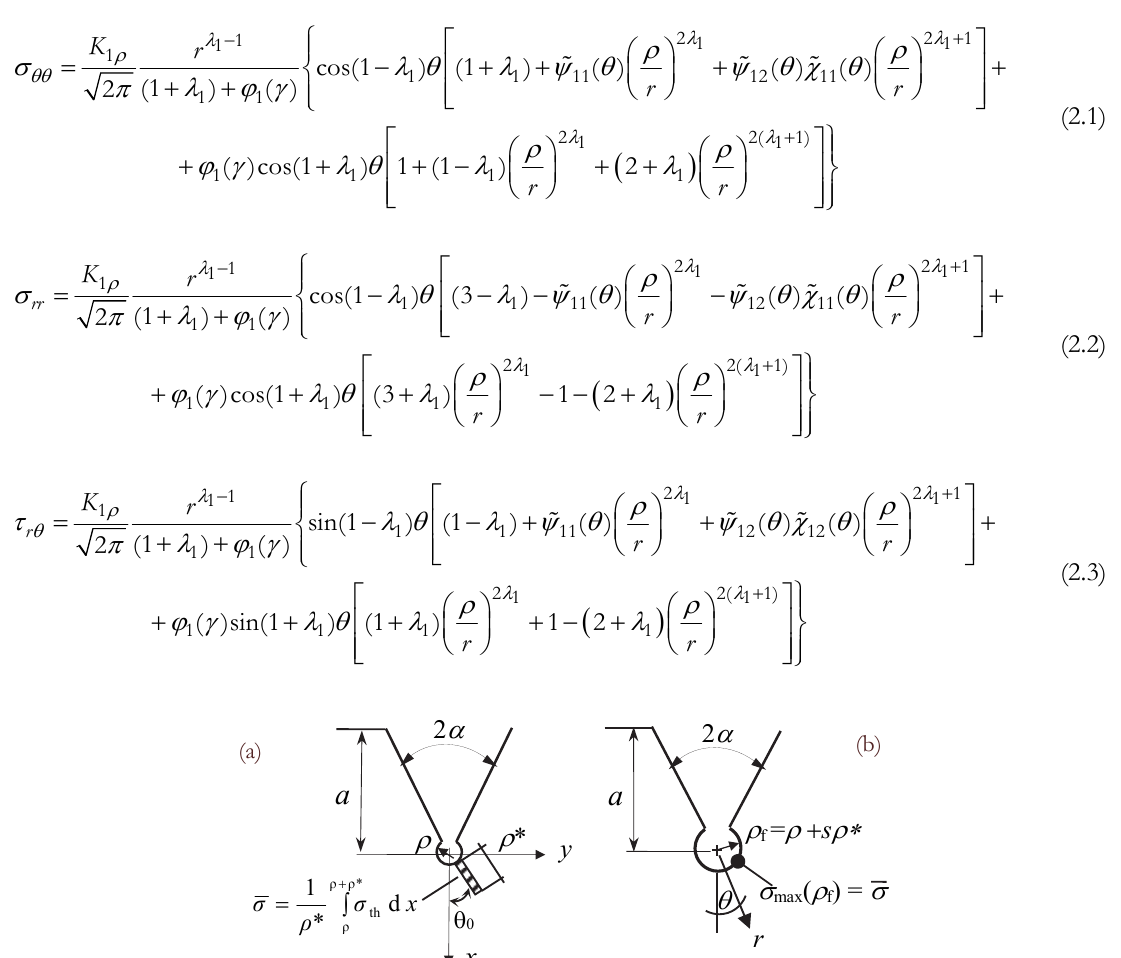
Figure 1: Fictitious notch rounding concept applied to mixed mode loading (mode 1+2): real root hole notch with stress averaged over  * in direction of crack propagation (a) and substitute root hole notch with fictitious notch radius  f producing  max =  (b). The parameter  1 is Williams’ [30] mode 1 eigenvalue, which is dependent on the notch opening angle 2 